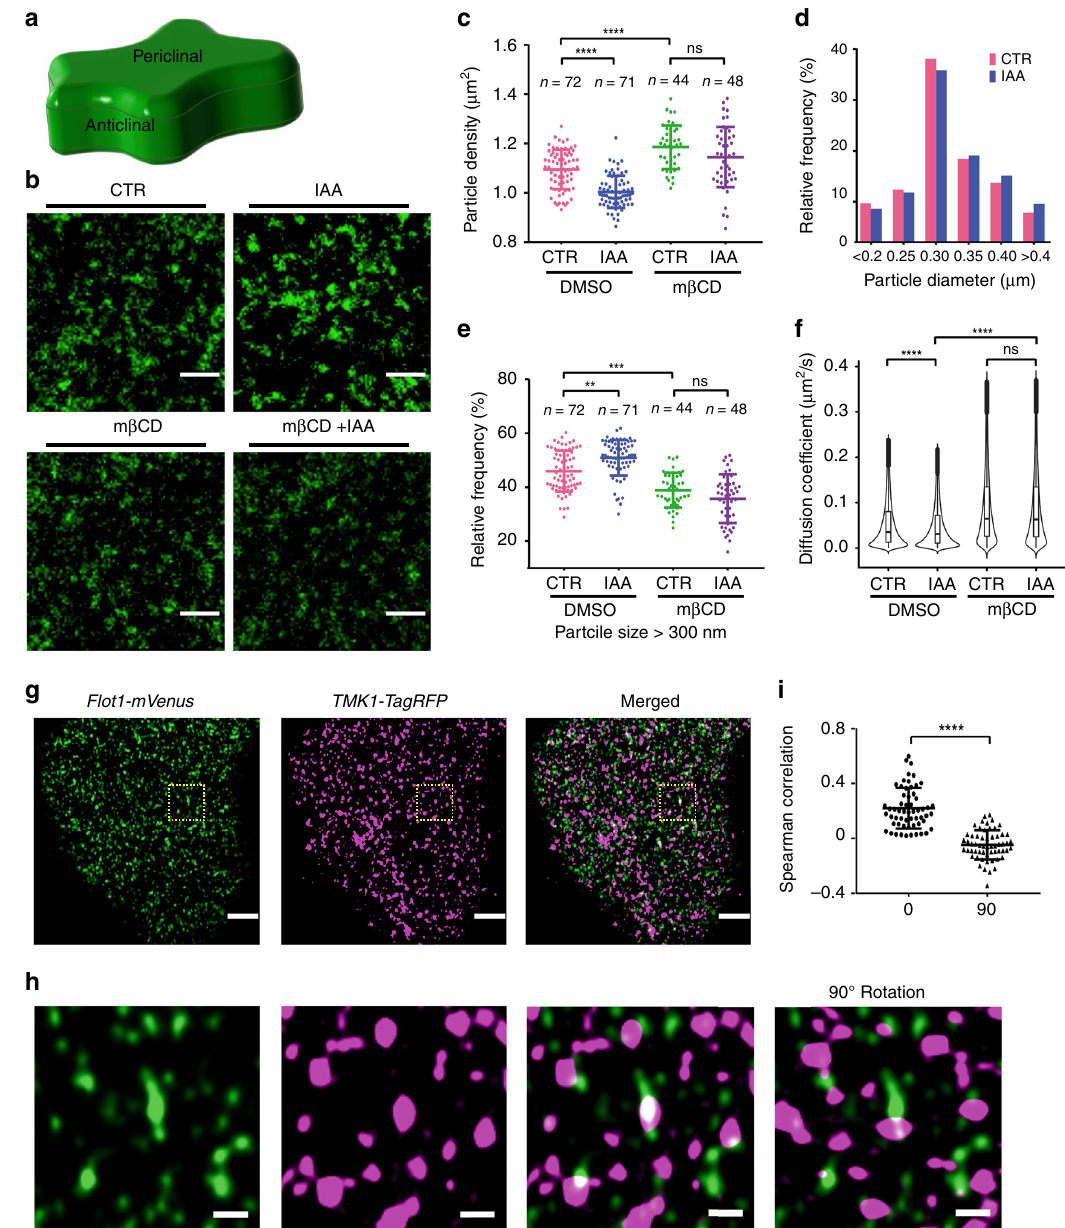
Fig. 3 Auxin promotes TMK1 nanoclustering in a sterol-dependent manner. a The 3D view of the pavement cell (PC). b Representative TIRF images of PCs expressing TMK1::TMK1-GFP with or without the IAA (100 nM, 10 min) treatment and the methyl- β -cyclodextrin (m β CD, 10 mM, 30 min) pretreatment. c Quantitative comparison of the TMK1-particle density in different treatments. d Histogram of TMK1-particle size distribution in control and IAA-treated cells. e Relative frequency of TMK1 particles with size larger than 300 nm. Data in c and e are presented as mean ± SD, and n represents the number of independent cells. f Comparison of diffusion coef fi cients of TMK1 particles in different treatments. The violin plot shows the distribution of the original diffusion coef fi cients without the log transformation. The distribution of log-transformed diffusion coef fi cients is shown in Supplementary Fig. 5. The number of particles analyzed in each treatment (from left to right) are 156,480, 131,187, 98,267, and 107,269, respectively. Statistical signi fi cance of treatment effects was evaluated on the overall diffusion coef fi cient of each treatment. CTR, control. Data in c , d , e , and f ) are representative of three independent experiments with the same pattern. g – i Colocalization analysis of PCs co-expressing fl otillin1:: fl otillin1-mVenus and TMK1::TMK1-tagRFP. g Representative Airyscan images. The yellow dashed boxes indicate the regions depicted in h . To test the speci fi c colocalization, the merged image was generated by rotating the image from the red channel with respect to the image from the green channel by 90°, a condition in which only random colocalization can be observed 78 . i A statistical analysis comparing Spearman ’ s rank-correlation coef fi cients in nonrotated (0°) and 90° rotated images. The signi fi cantly higher correlation coef fi cients obtained in nonrotated images than in 90° rotated images suggests that the observed colocalization is not due to random chance. Data were obtained from 58 regions of 20 cells in two independent experiments. Scale bars: 2 µ m b , 3 µ m g , and 0.5 µ m h . ** P ≤ 0.01, *** P ≤ 0.001, **** P ≤ 0.0001; ns, not signi fi